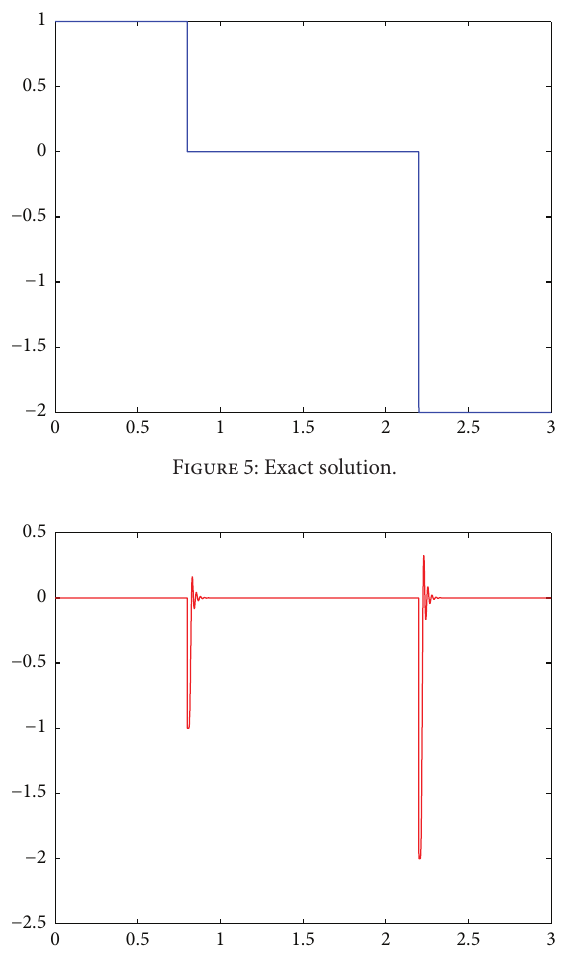
Figure 6: The error between numerical result and exact solution.